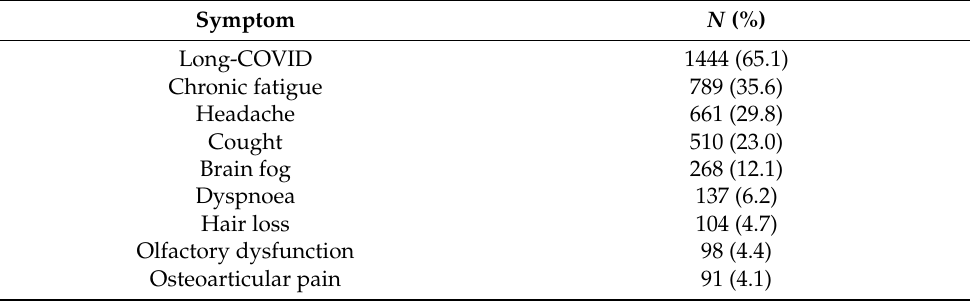
Table 2. Prevalence of long-COVID-19 syndrome in the study group, detailing the most common clinical